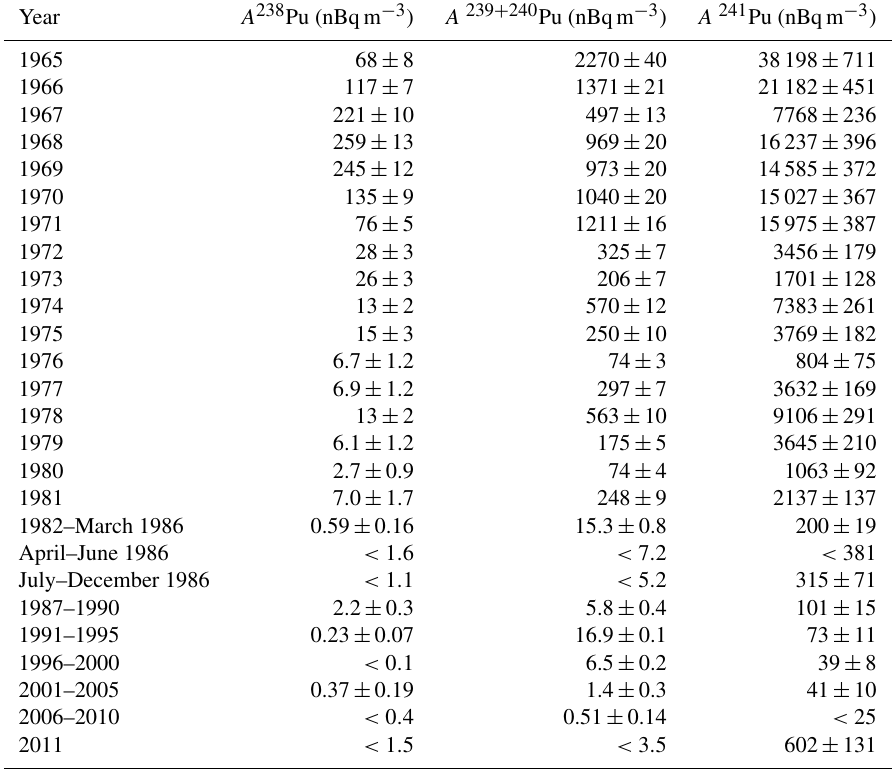
Table 1. The atmospheric-activity concentrations of 238 Pu, 239 + 240 Pu and 241 Pu in Rovaniemi, Finnish Lapland. The activity values have been decay-corrected to the middle point of the sampling period. A : activity